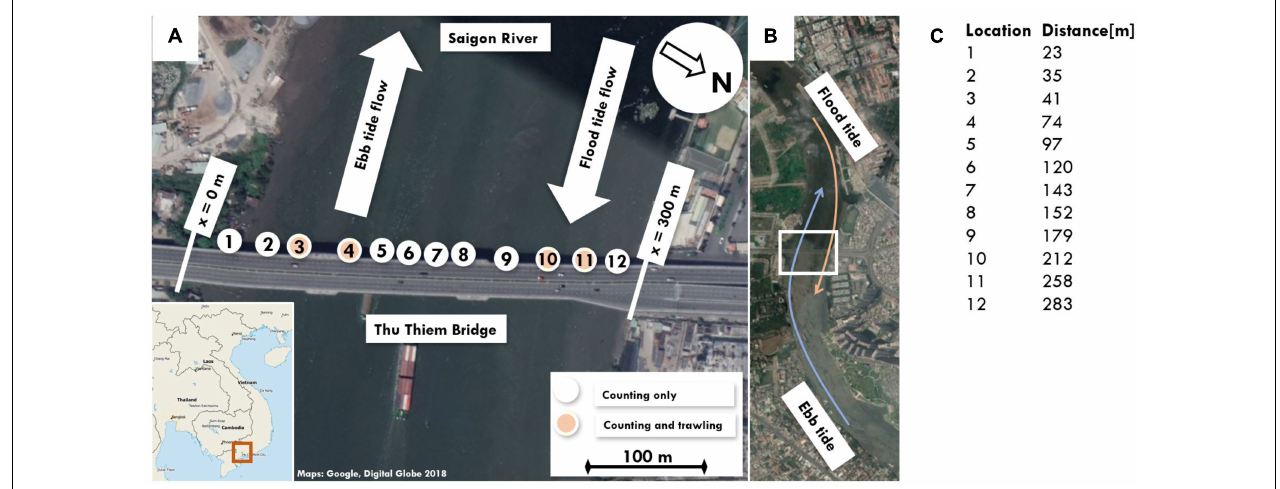
FIGURE 2 | (A) Measurement location and observation sites on the Thu Thiem bridge. Note that the observation sites run from 1 (south) to 12 (north). Arrows project the observed influence of tidal dynamics on plastic flux direction. Bridge-mounted trawls were deployed at location 2 and 3 during ebb tide flow and at location 10 and 11 during flood tide flow (Map: Google, Digital Globe, 2018). (B) Overview of the curvature of the river, with an indication of the location of the highest plastic concentration during flood and ebb tides. (C) Location of each observation